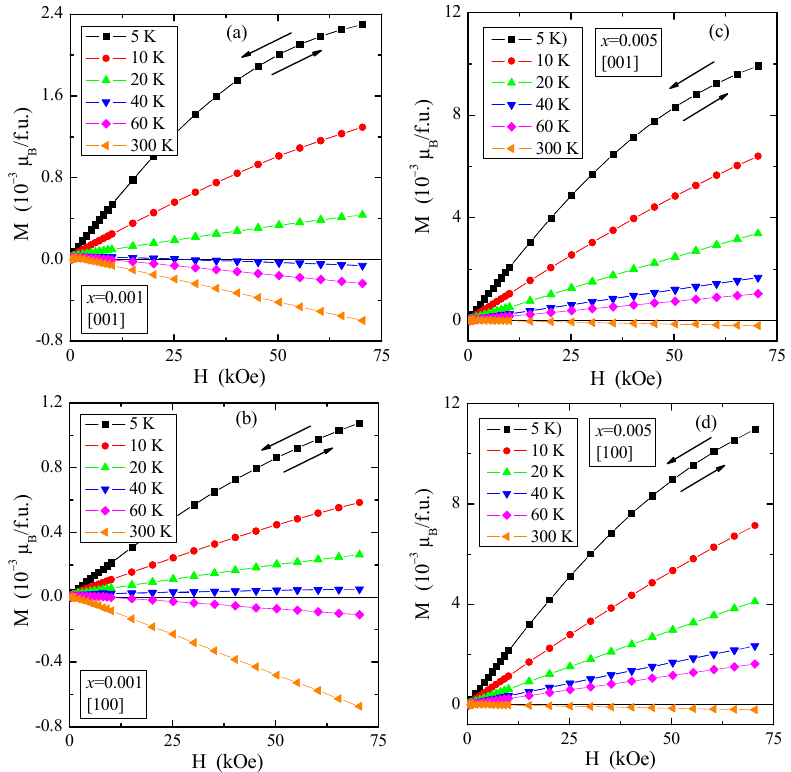
Figure 5. Magnetization M vs. magnetic field H of PNMWO single crystals: ( a ) x = 0.001 and [001], ( b ) x = 0.001 and [100], ( c ) x = 0.005 and [001], ( d ) x = 0.005 and [100], recorded at 5, 10, 20, 40, 60 and 300 K. A run of magnetic field is indicated by arrows.